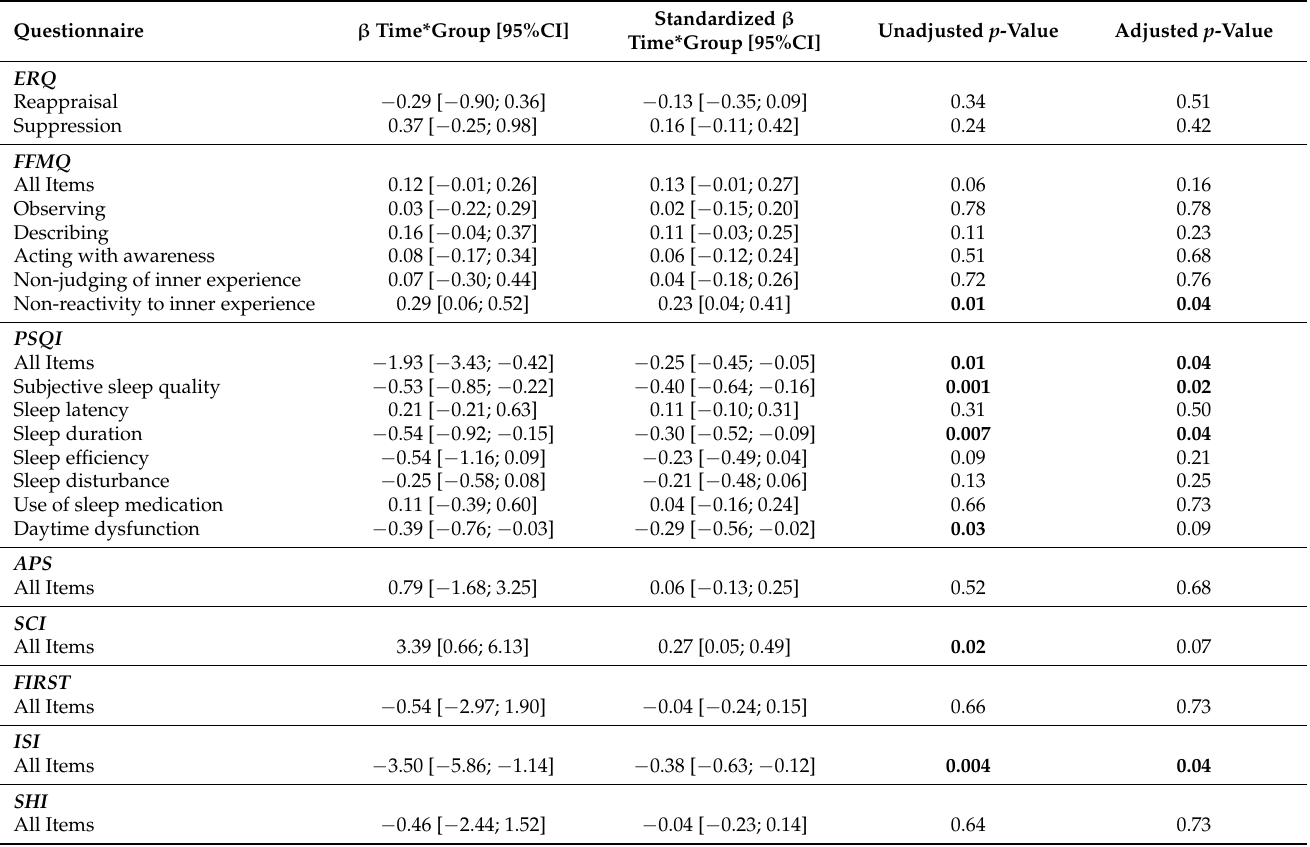
Table 3. Between-group differences obtained using a linear mixed model. For each questionnaire and subscale, both standardized and non-standardized β coefficients of time*group interaction with their 95% CI and p -value are